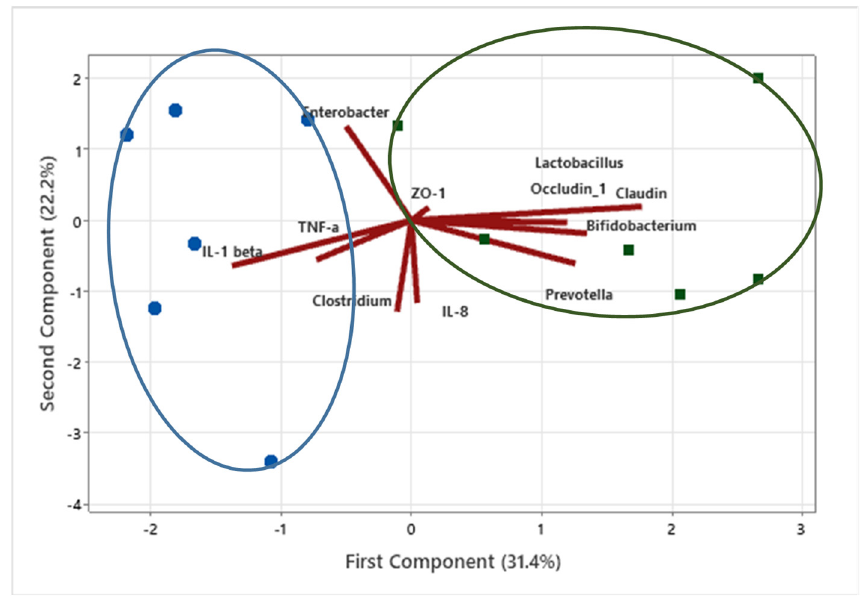
Figure 5. Estimation of the relationships between inflammation, microbiota and junction proteins in the colon samples using principal component